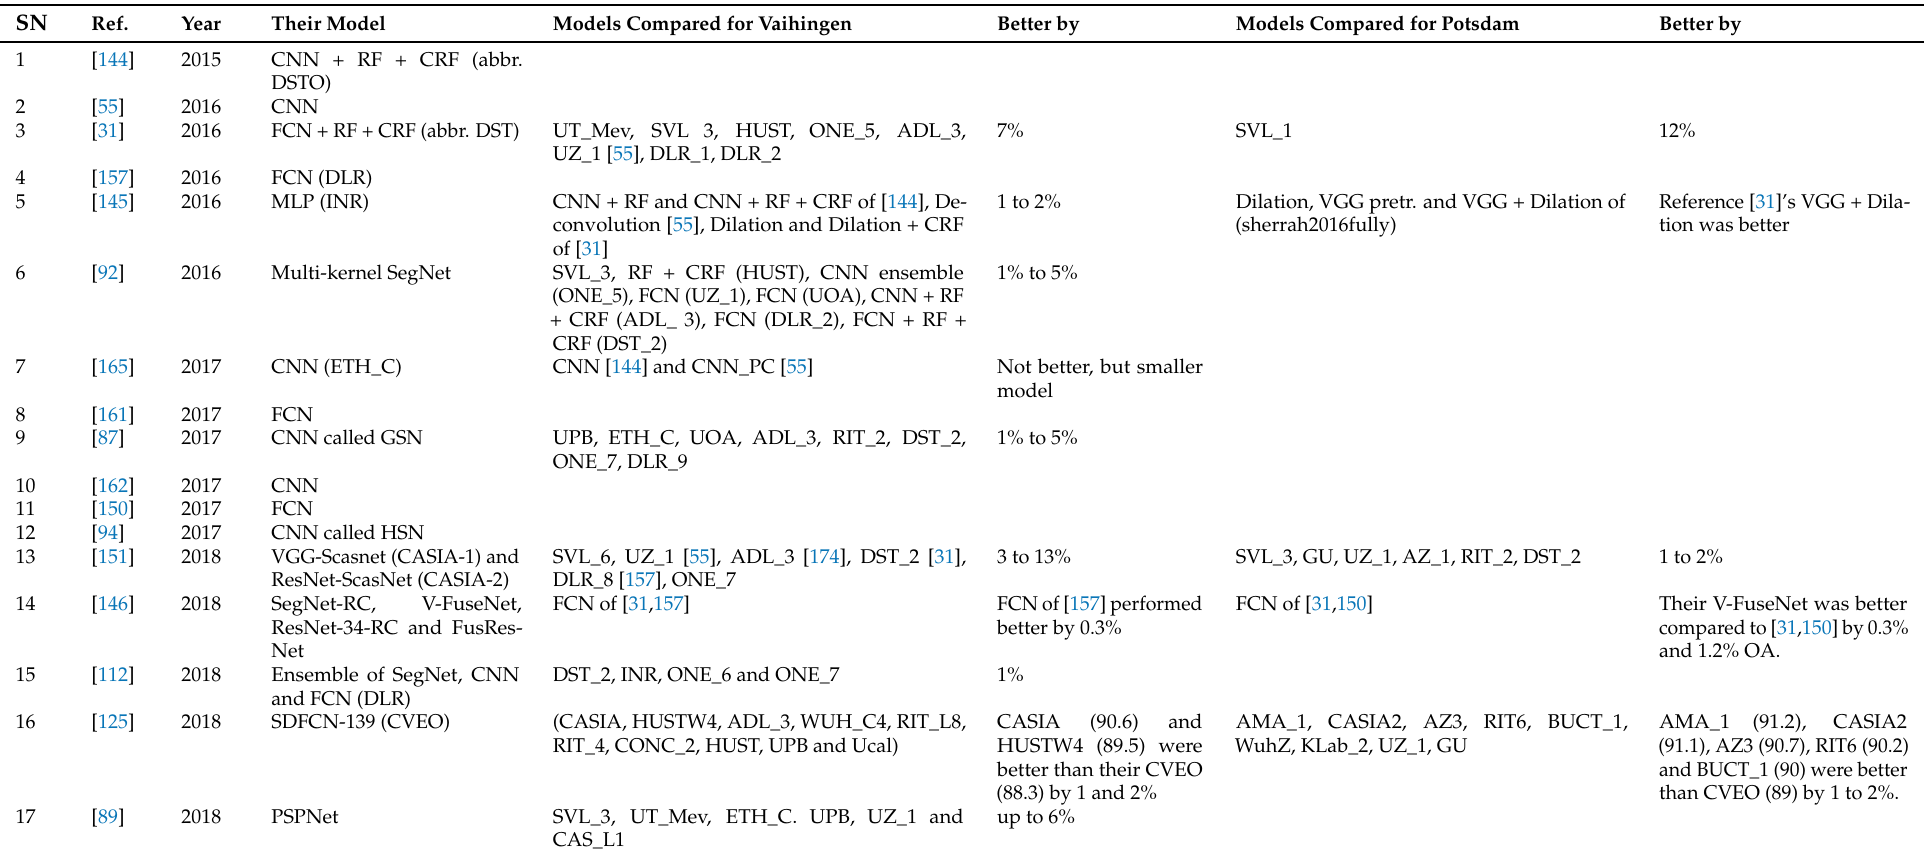
Table A2. Comparison of Papers Using ISPRS 2D Semantic Labeling